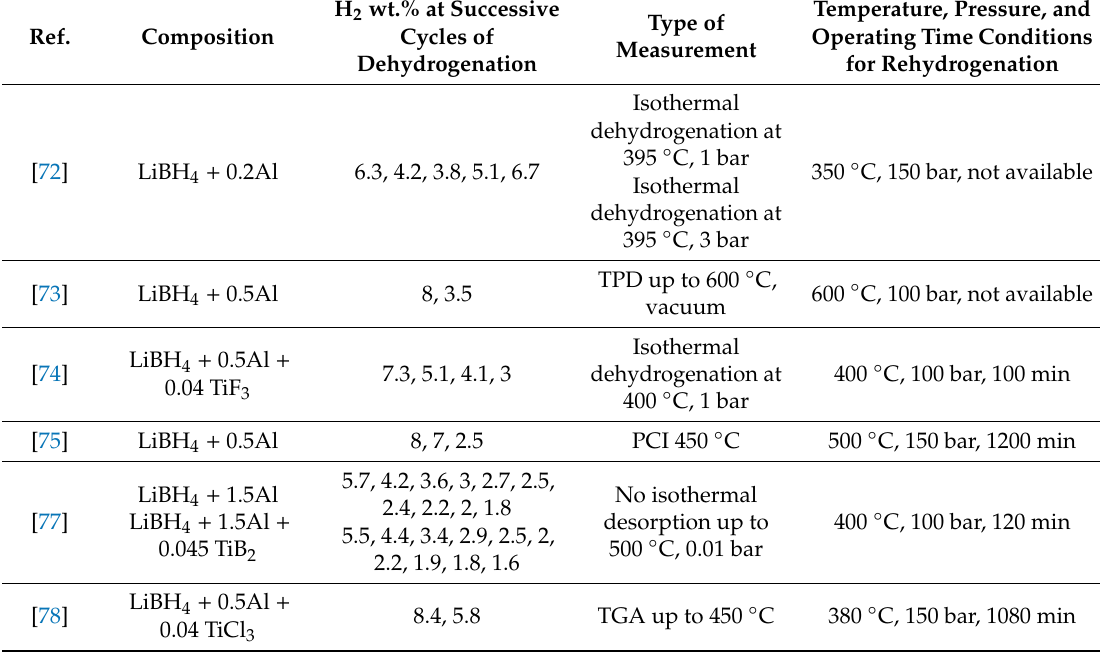
Table 4. Experimental H 2 properties for the LiBH 4 -Al